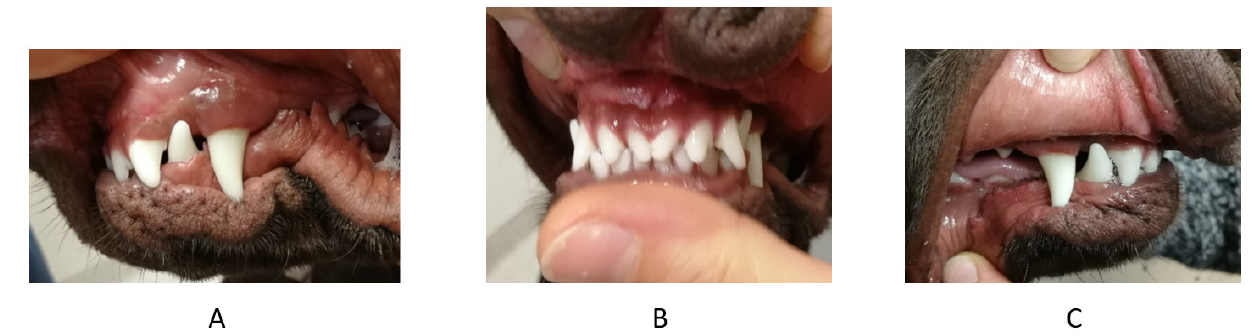
Figure 7. Second case. Intraoral photographs in full occlusion after treatment—press of the mandible against the maxilla. ( A ) left side, ( B ) en face, ( C ) right side.